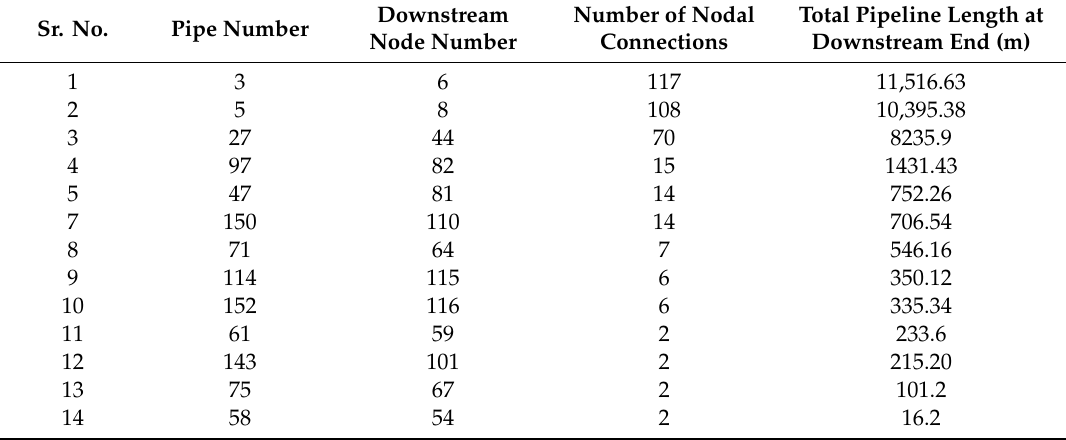
Table 2. Preference list of optimal pressure-reducing valve localizations obtained from the proposed nodal matrix